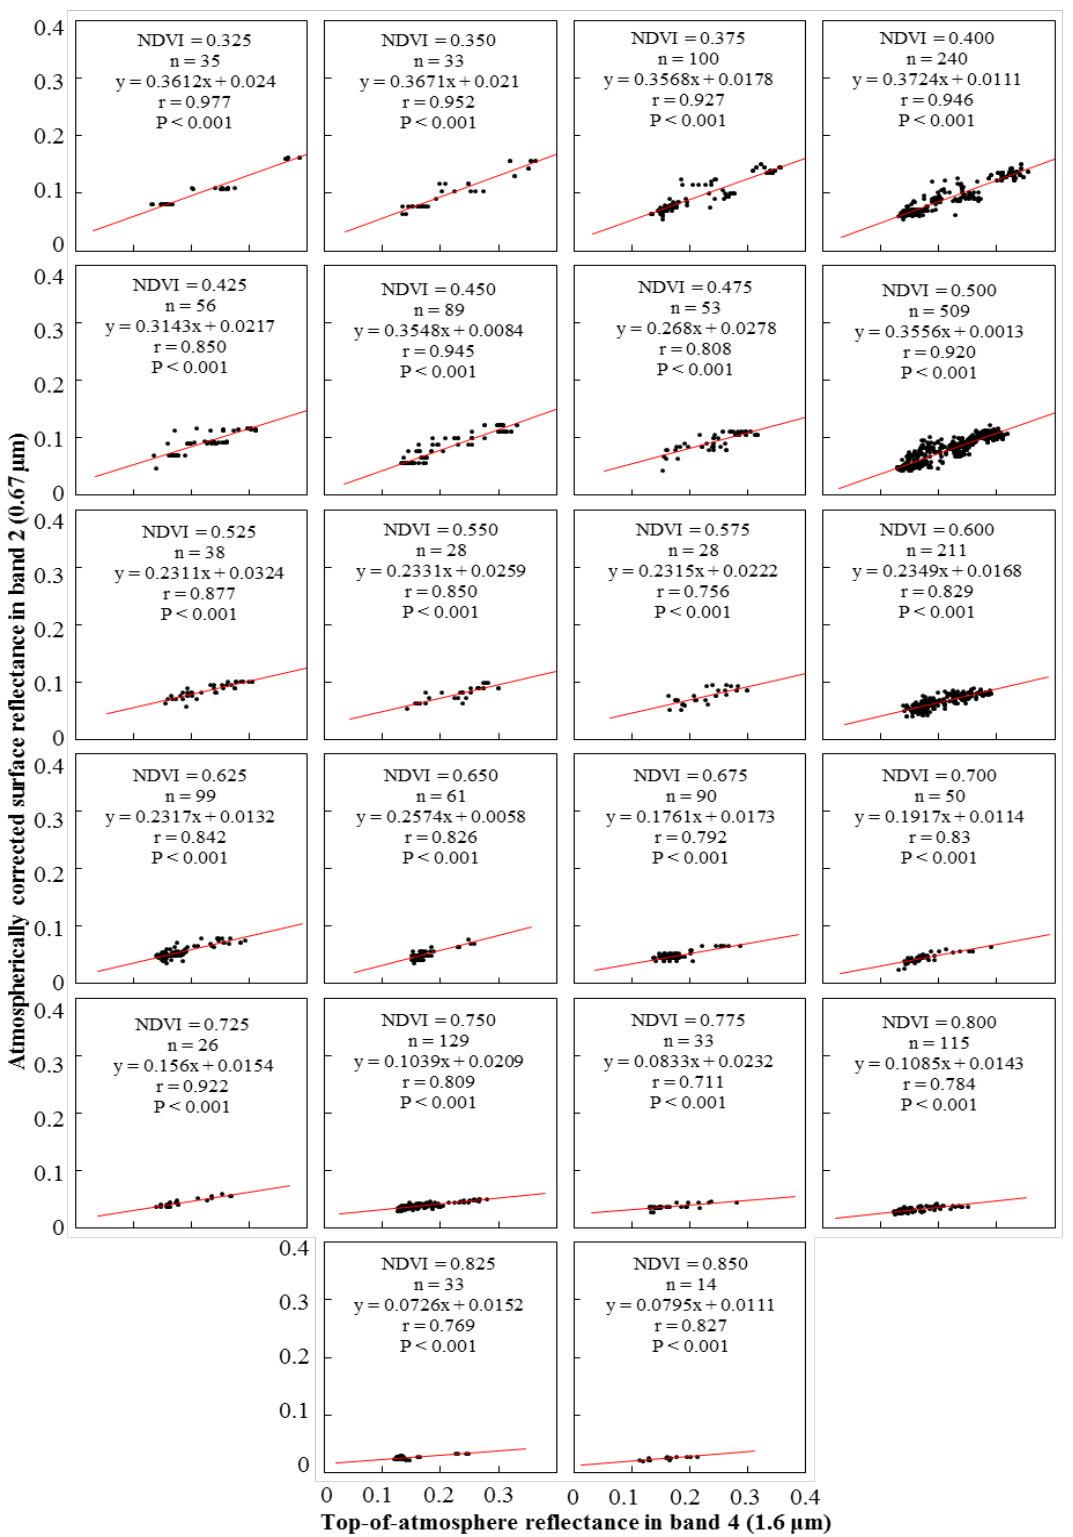
Figure 3. Relationship between TOA reflectances at 1.6 µ m and surface reflectance at 0.67 µ m varying with different NDVI values (All data points in each graph fall within NDVI value ± 0.0001.).